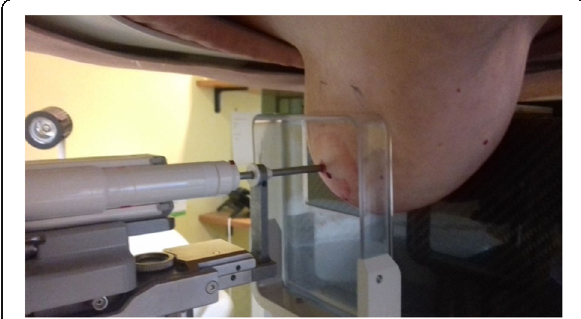
Fig. 2 Mammography-guided (stereotactic) vacuum-assisted biopsy. The patient is in prone position lying on the table over the field of view of the image, with the breast pendent by gravity (she does not see the procedure). After local anaesthesia, the needle is guided to the lesion by the computer on the basis of specifically acquired mammographic images